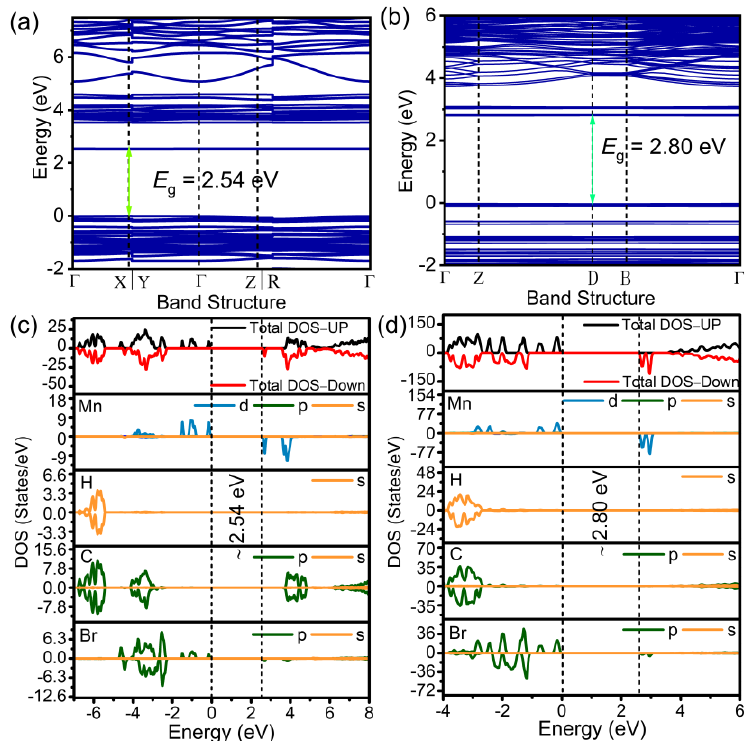
Figure 4. Electronic energy band structures of ( a ) (C 13 H 14 N) 2 MnBr 4 and ( b ) (C 13 H 26 N) 2 MnBr 4 . The total and orbital projection of partial density of states of ( c ) (C 13 H 14 N) 2 MnBr 4 and ( d ) (C 13 H 26 N) 2 MnBr 4 .